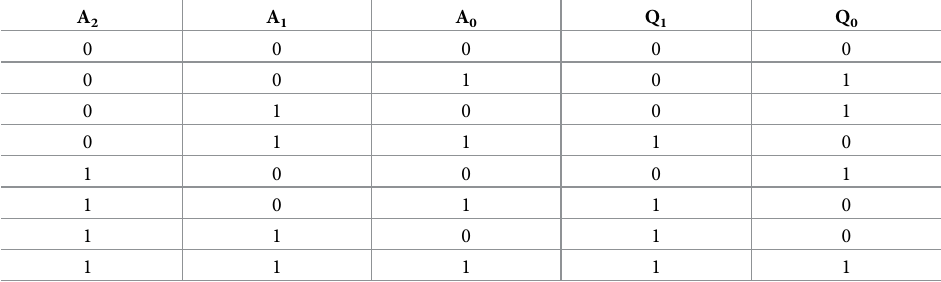
Table 4. Hamming weight function as an example objective function. Q 1 Q 0 presents the number of 1’s in the A